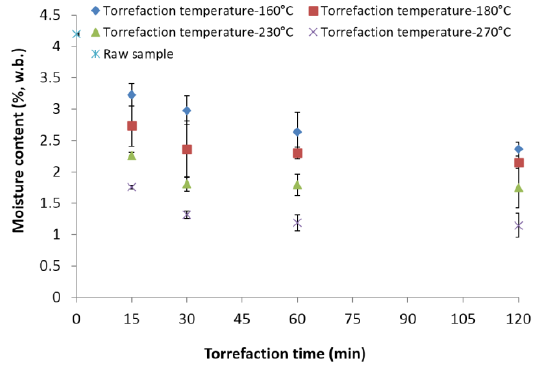
Figure 4. Moisture content in the ground lodgepole pine with respect to the torrefaction temperature and time.